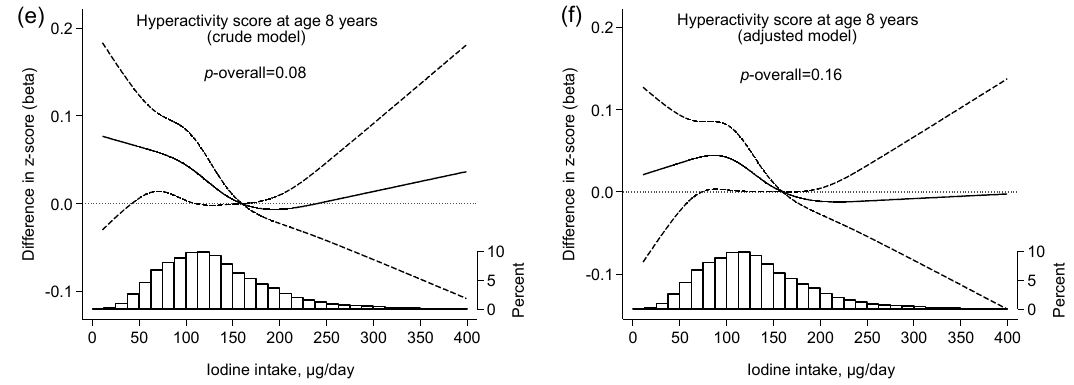
Figure 3. Association between maternal iodine intake from food and standardized score on maternally reported child ADHD symptoms at age eight years. Results are from multivariable regression analysis and restricted to non-users of iodine supplements during the first half of pregnancy ( n = 19,086 mother-child pairs). Iodine intake was modelled by restricted cubic splines (four knots), and the reference level was set to 160 µg/day. Dashed lines represent 95% confidence limits. The histograms ( e , f ) illustrate the distribution of iodine intake. Crude models ( a , c , e ) were adjusted for maternal energy intake and for random effects of sibling clusters. Adjusted models ( b , d , f ) were additionally adjusted for maternal age, parity, education, body mass index, smoking in pregnancy, fiber intake, child sex, and birth season.